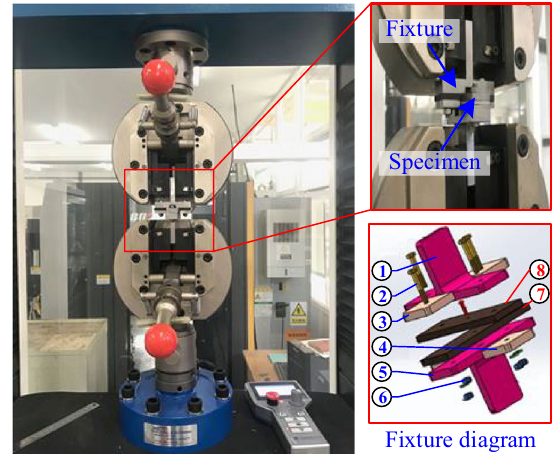
Figure 2 Experiment set-up of the pull-through test for